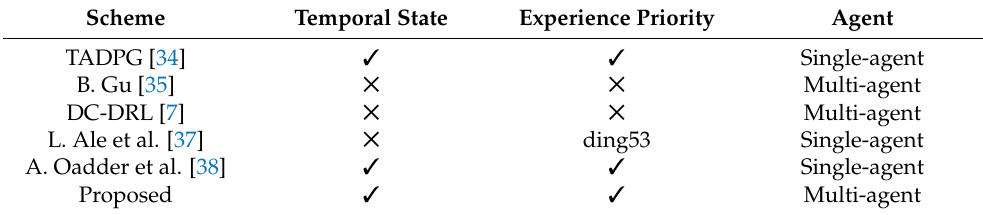
Table 1. Summary of recent offloading